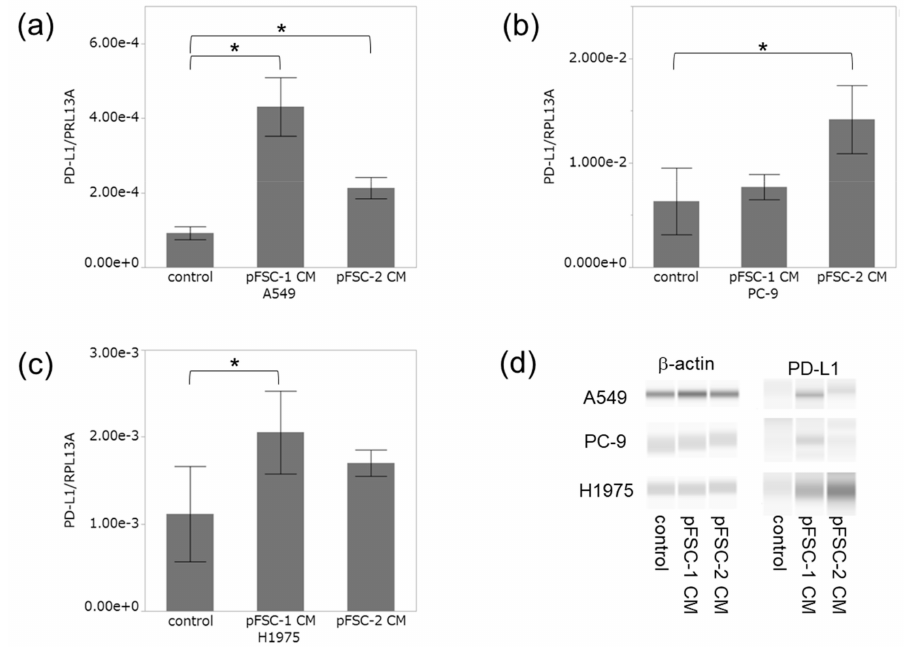
Figure 4. E ff ect of conditioned medium (CM) derived from cancer-associated fibroblasts (CAFs) on PD-L1 expression in lung cancer cell lines. E ff ect of CM from pFSC-1 and -2 on PD-L1 mRNA level in A549 ( a ), PC-9 ( b ), and H1975 ( c ). Data were presented as means ± SD from three independent experiments. * p < 0.05 vs. control. ( d ) Protein level of PD-L1 treated with CM in A549, PC-9, and